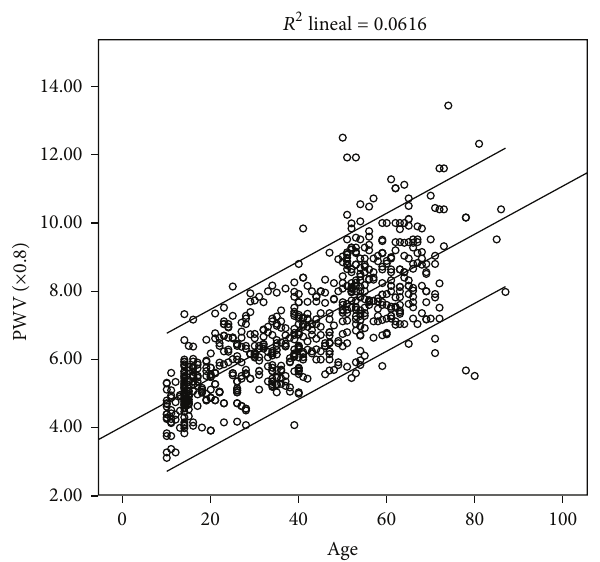
Figure 1: Scatter graph showing the relationship between mean PWV (mean and CI 95%) and age in the study population ( n = 780).